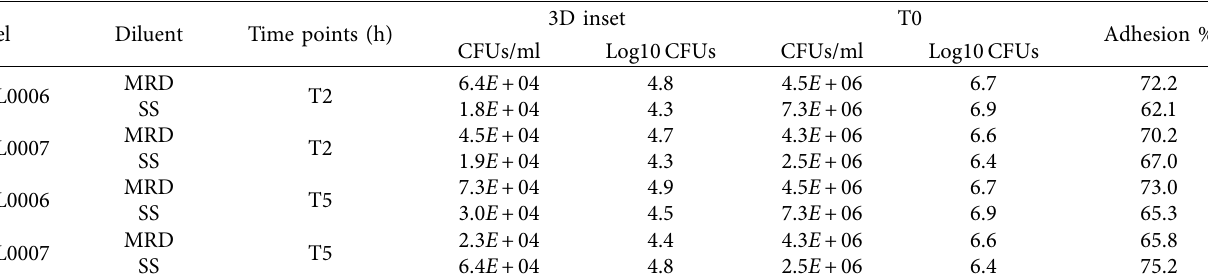
Table 4: Bacteria released from lipogel samples, incubated in MRD or SS, and the calculated % of adhesion to hydroxyapatite disks. Gel